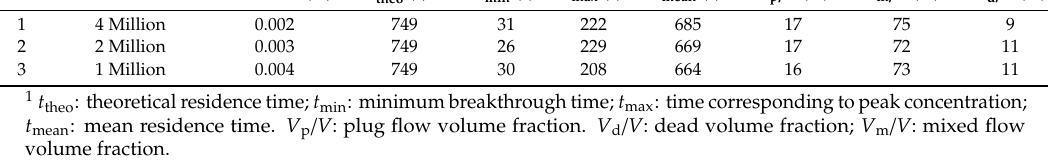
Table 3. The computational RTD parameters and volume fraction of flow with di ff erent mesh size. Mesh